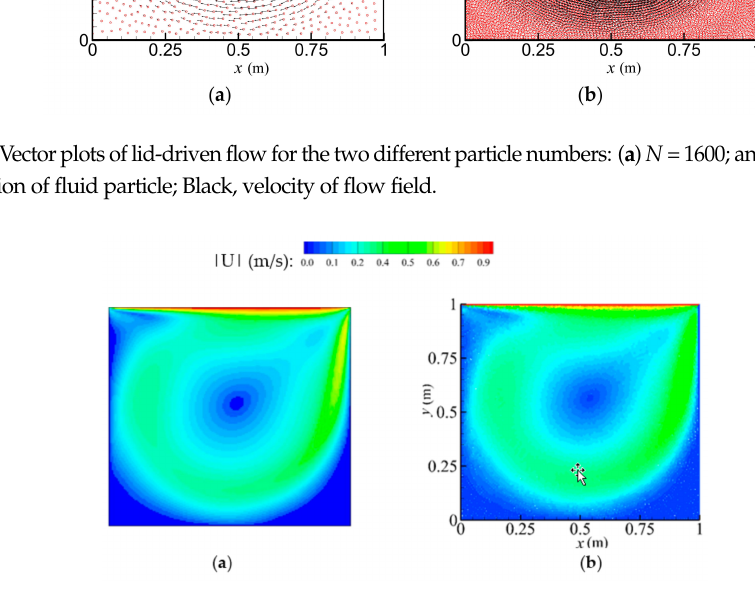
Figure 8. Velocity amplitude patterns of the lid-driven flow computed by ( a ) OpenFOAM; and ( b ) ISPH